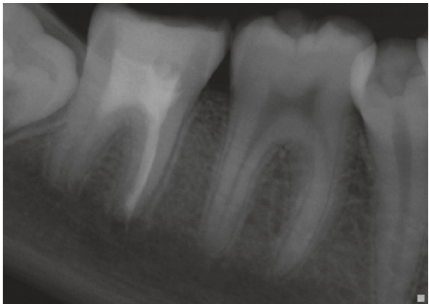
Figure 9: Radiograph at 24 months’ recall: complete disappearance of the radiolucent